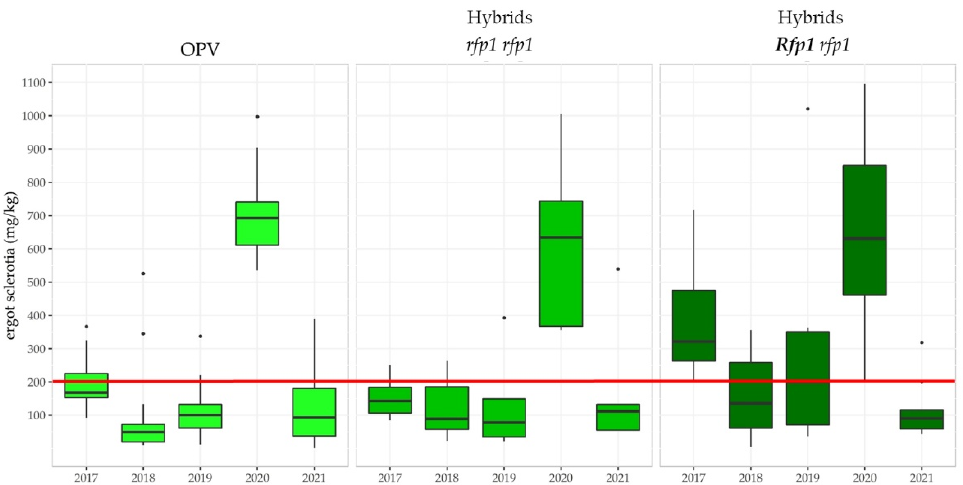
Figure 7. Ergot severity in rye upon natural infection detected in samples from open-pollinated (OPV) and hybrid cultivars merchandized without ( rfp1 rfp1 ) and with ( Rfp1 rfp1 ) the restorer gene Rfp1 across 54 environments (location x year combinations). The number of environments varied between 8 (2019) and 15 (2020). The threshold of 200 mg ergot sclerotia/kg harvest valid from July 1 st , 2024 is indicated in red. Data source [89].